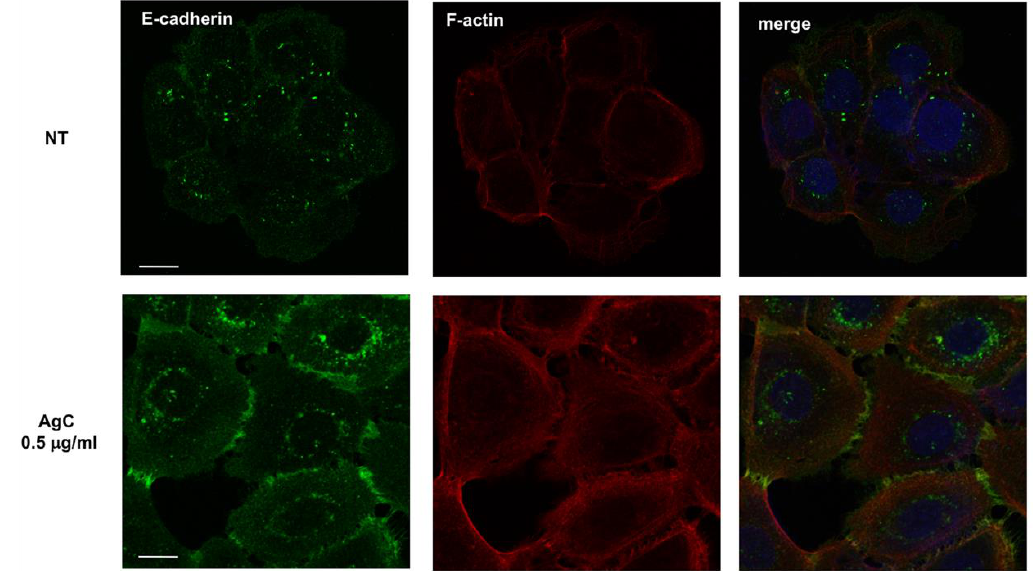
Figure 5. E-cadherin localization in HaCaT cells upon AgC treatment. Cells were allowed to adhere onto coverslips for 24 h and then treated with 0.5 µ g / mL AgC for 8 h. Cells were then fixed and subjected to IF with an anti-E-cadherin antibody followed by TRITC-conjugated phalloidin to visualize the actin cytoskeleton. Representative images of E-cadherin subcellular localization and phalloidin are shown. Merged images also show DAPI staining to visualize the nuclei. Images were taken with a Zeiss confocal laser-scanning microscope Axio Observer (scale bar, 15 µ M). A × 40 objective was used and image analysis was performed using ImageJ.